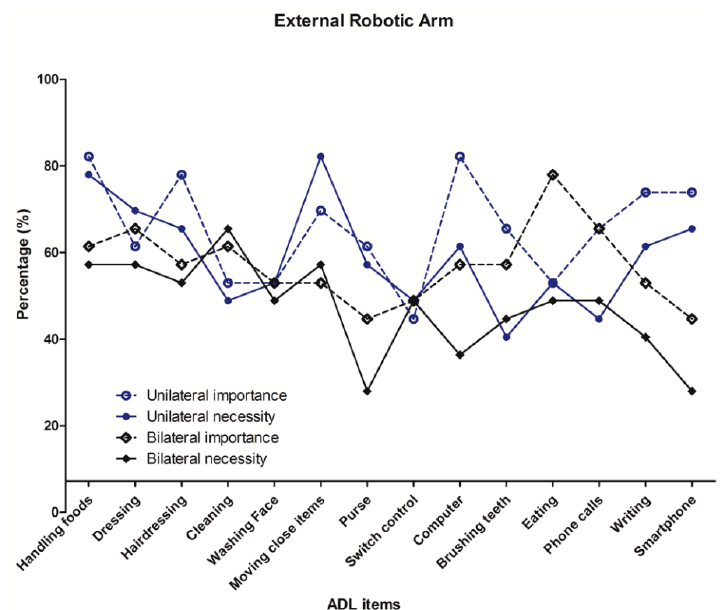
Figure 1. The percentage of respondents who replied ‘important’ or ‘very important’ for importance (dotted line) and ‘necessary’ and ‘highly necessary’ for necessity (solid line) of an external robotic arm to each activity of daily living (ADL) function in each impairment group (unilateral impairment group: circle, bilateral impairment group: rhombus). The ADLs in the x -axis are in the order of high to low dependency for all survey participants.